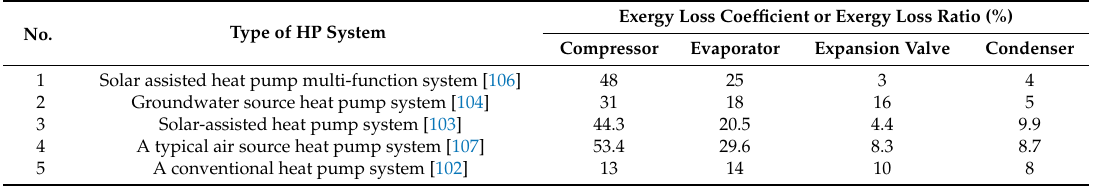
Table 16. The exergy loss coefficients or ratios of main components in different heat pump